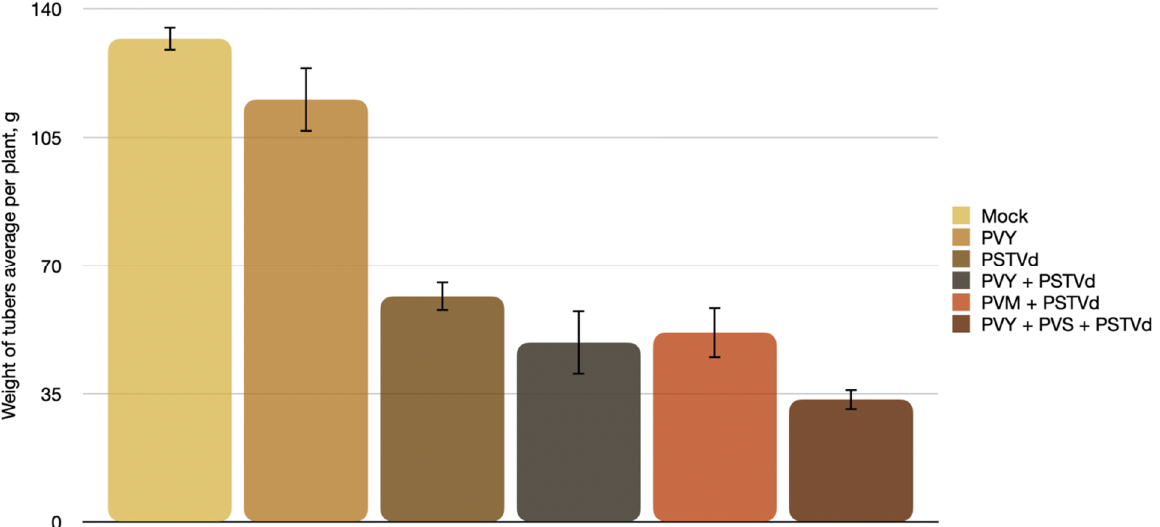
Figure 14. Weight of tubers per plant of PSTVd-infected, viral-infected, and viroid/viral-mixed infected plants regardless of cultivar, mean value for: Mock—11 cv., 66 plants; PVY—2 cv., 4 plants; PSTVd—11 cv., 35 plants; PVY + PSTVd—6 cv., 9 plants; PVM + PSTVd—6 cv., 8 plants; PVY + PVS + PSTVd—3 cv., 5 plants. According to Student’s t -test with Bonferroni correction ( p < 0.05), differences significant between mock and PSTVd, PVY + PSTVd, PVM + PSTVd, and PVY + PVS + PSTVd.